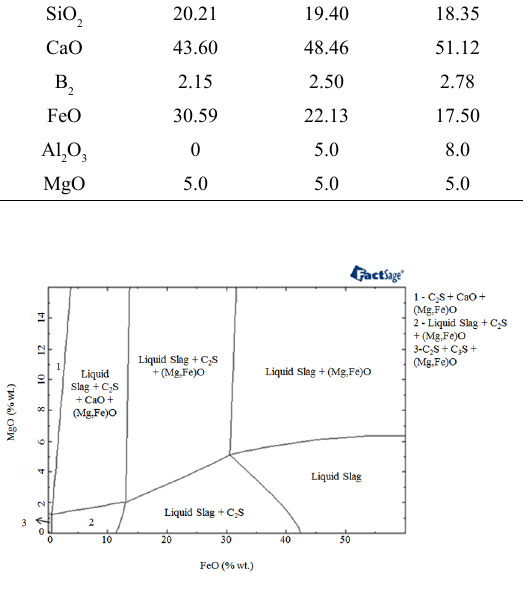
=2.15 and T = 1600°C. 2